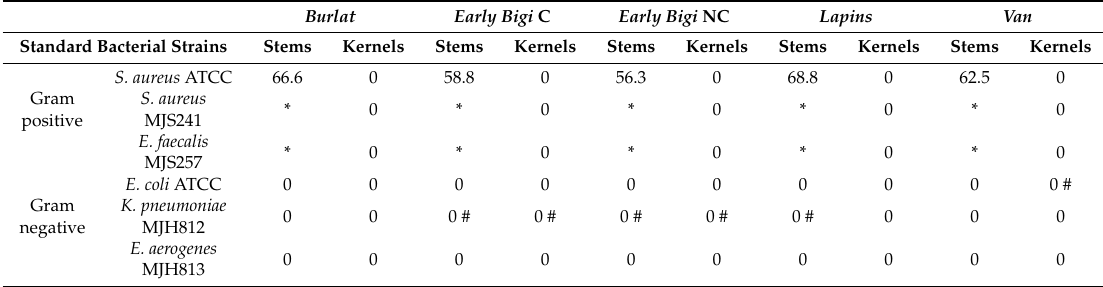
Table 5. Antimicrobial activity (% RIZD) of cherry stems and kernels relatively to antibiotic gentamicin.